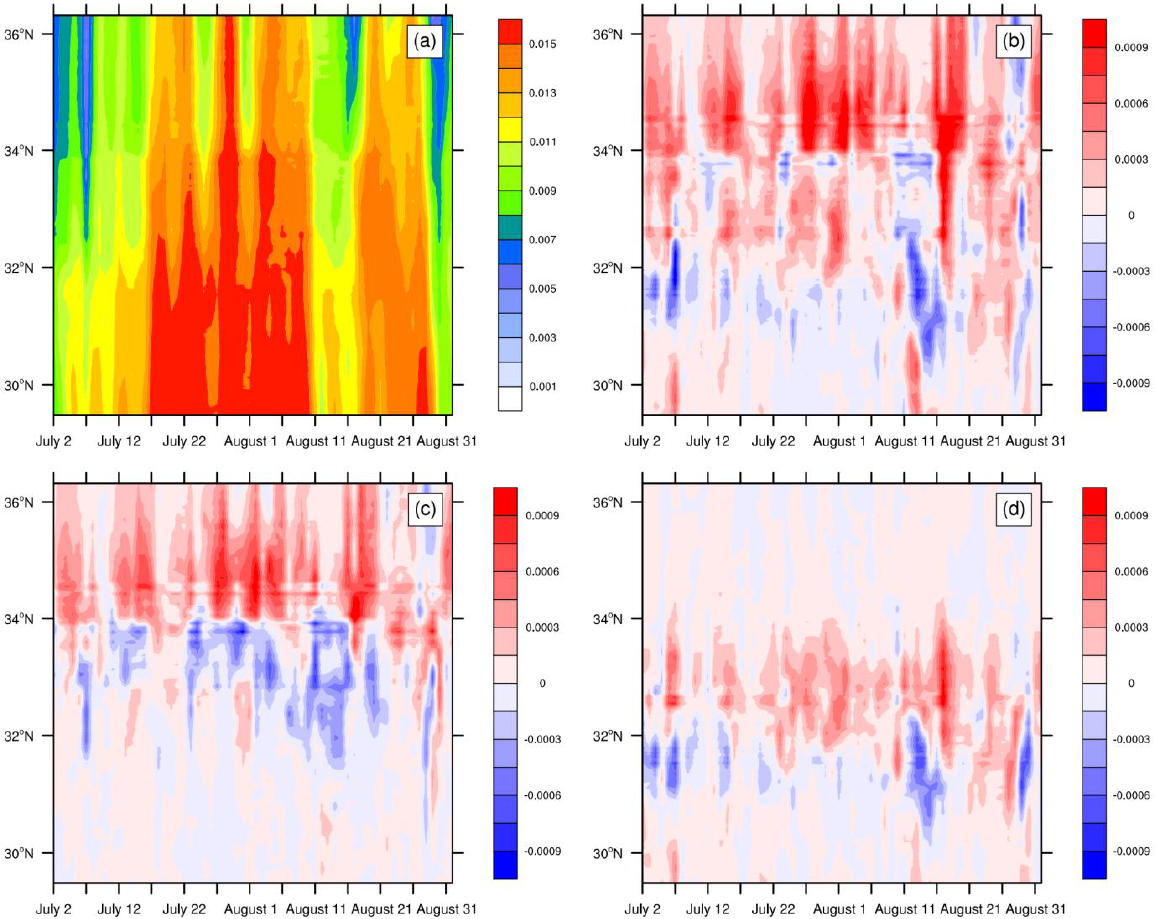
Figure 7. Time – latitude diagrams of water vapor mixing ratio (kg kg −1 ) at 850 hPa averaged in domain 3 in CTRL ( a ). Panels ( b – d ) are the differences ( b ) between LowQD and CTRL (LowQD minus CTRL), ( c ) between LowQ and CTRL (LowQ minus CTRL), as well as ( d ) between LowD and CTRL (LowD minus CTRL), respectively. Blue (red) shading indicates negative (positive) variation.